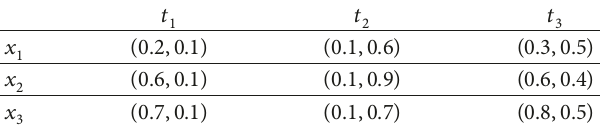
Table 10: TIFS A .